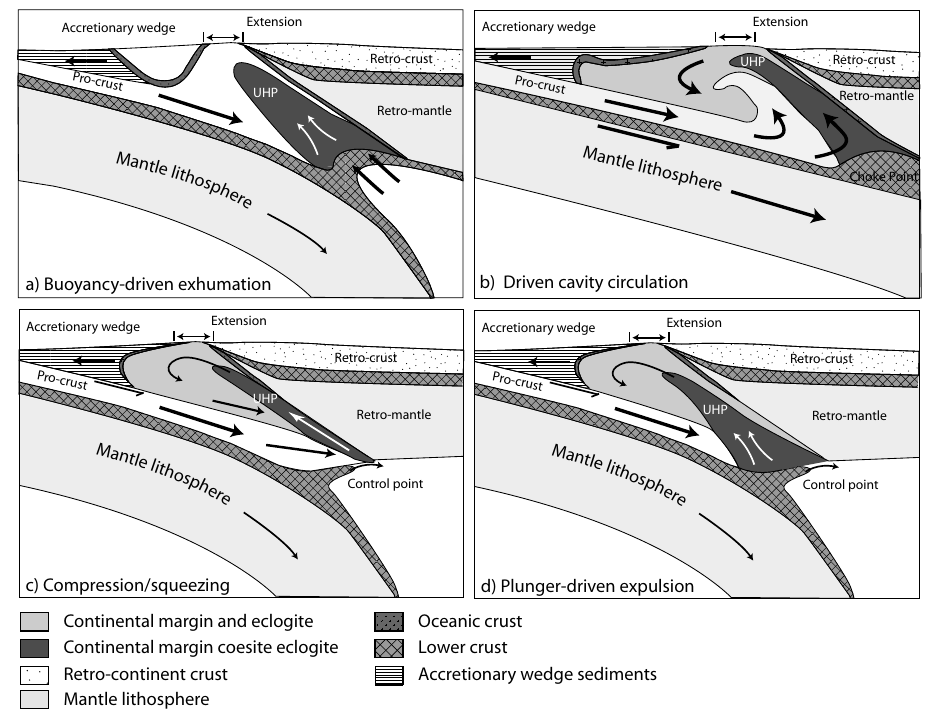
Fig. 2. Schematic diagram showing example styles of exhumation. (a) Buoyancy-driven exhumation, where upwards motion is driven pri- marily by the buoyancy force of the exhuming material; (b) Driven cavity flow, where upwards motion is driven by circulatory flow initiated by the traction of the subducting plate; (c) Compression/squeezing of weaker material between two stronger blocks (subducting plate and mantle wedge); and (d) Plunger-driven expulsion whereby weaker material in the channel is expelled upwards between a choke point at the base of the channel and stronger crust entering the channel. Modified from Warren et al. (2008b).